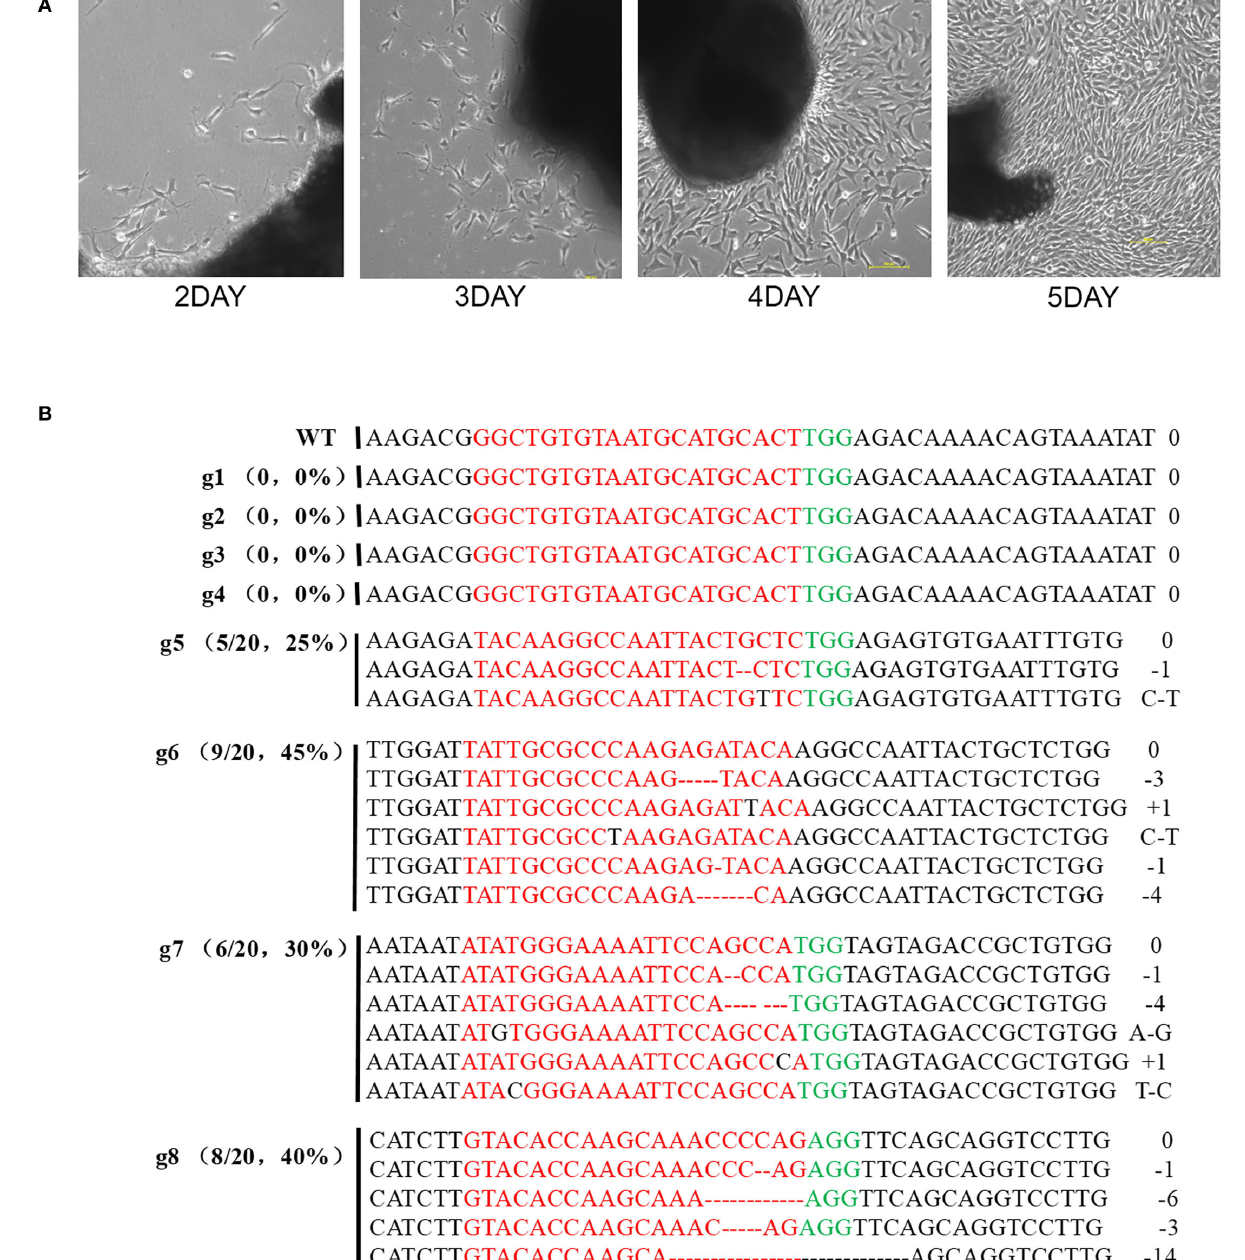
rabbits ( P < 0.05, n = 5). Furthermore, the bodyweight of MSTN - KO rabbits (3,572 ± 41.40 g) was significantly ( P < 0.01) more at 160 days as compared to the control WT rabbit (3,094 ± 69.54